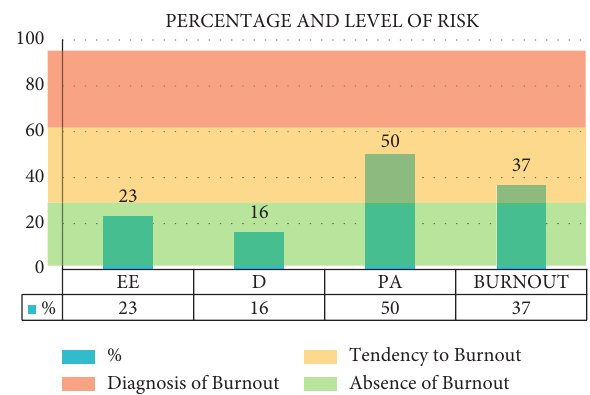
Figure 1: Risk levels of the total sample in dimensions EE, D, PA, and